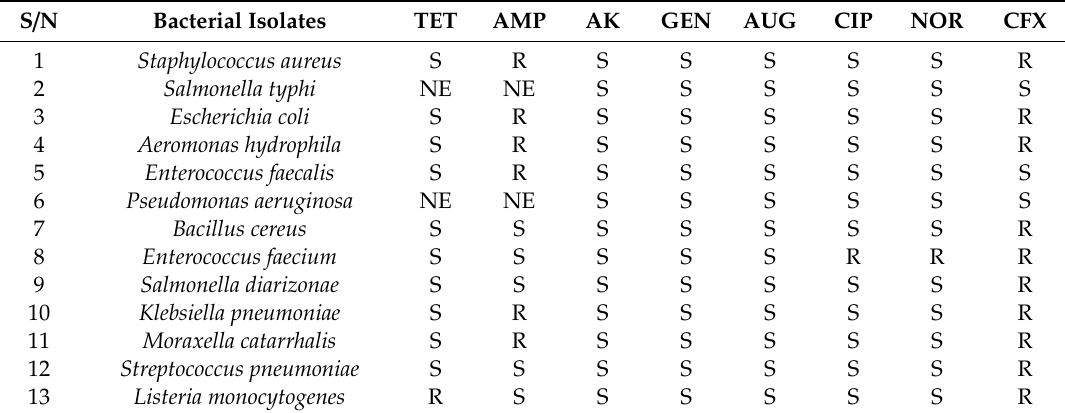
Table 2. Antibiogram resistance profiles of the isolates.